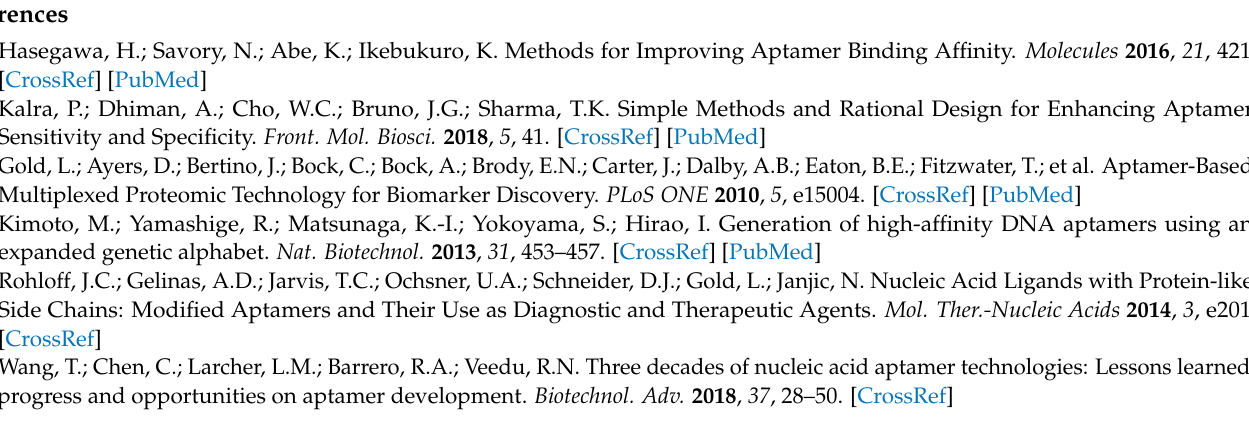
Figure S3: Optimal amount of modified aptamer. Figure S4: Evaluation of functionalized screen- printed electrodes, using fast chronoamperometry: (a) carbon screen-printed electrodes and (b) gold screen-printed